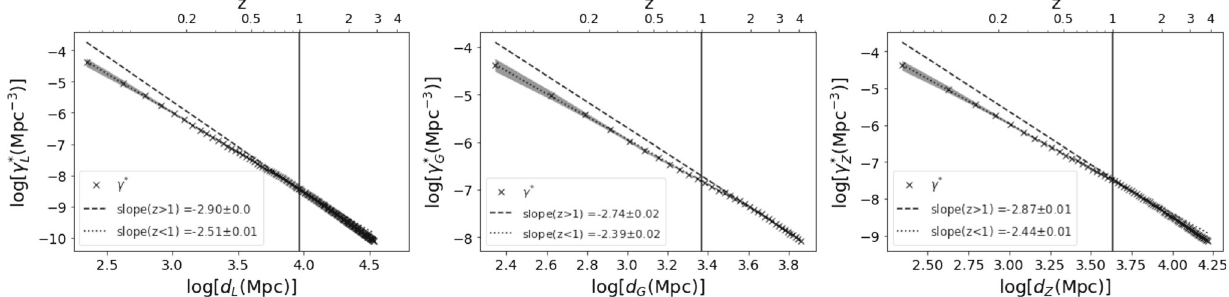
Fig. 15 Log–log graph of γ ∗ , γ ∗ and γ ∗ respectively vs. d L , d G and d z obtained with the red SPLASH quiescent galaxy subsample in the ranges L G z z < 1 and 1 ≤ z ≤ 4 and respective distance measures. All results were obtained considering H 0 = 70